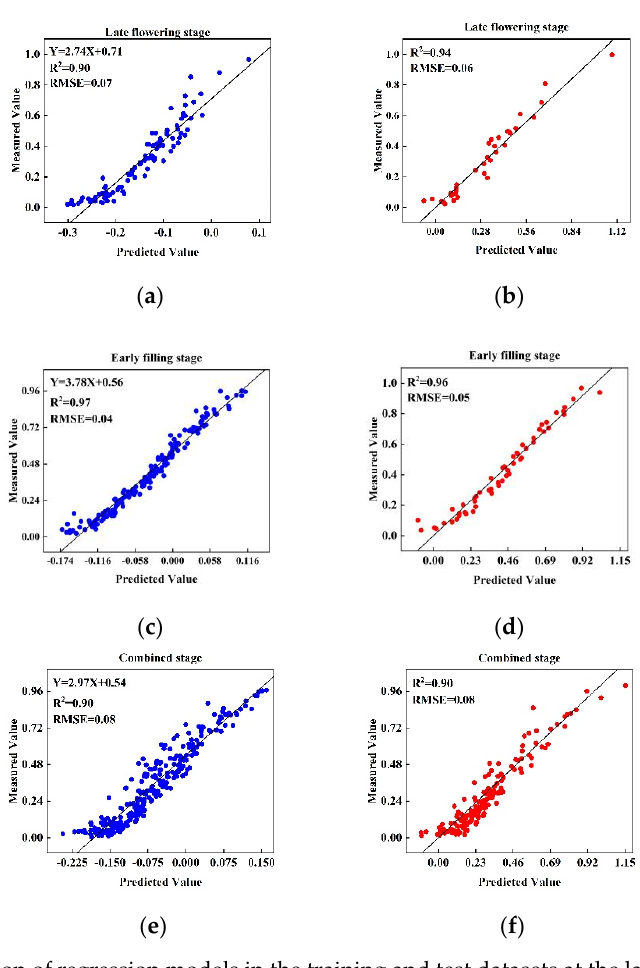
Figure 6. Evaluation of regression models in the training and test datasets at the late flowering stage ( a , b ), the early filling stage ( c , d ) and the combined stage ( e , f ).